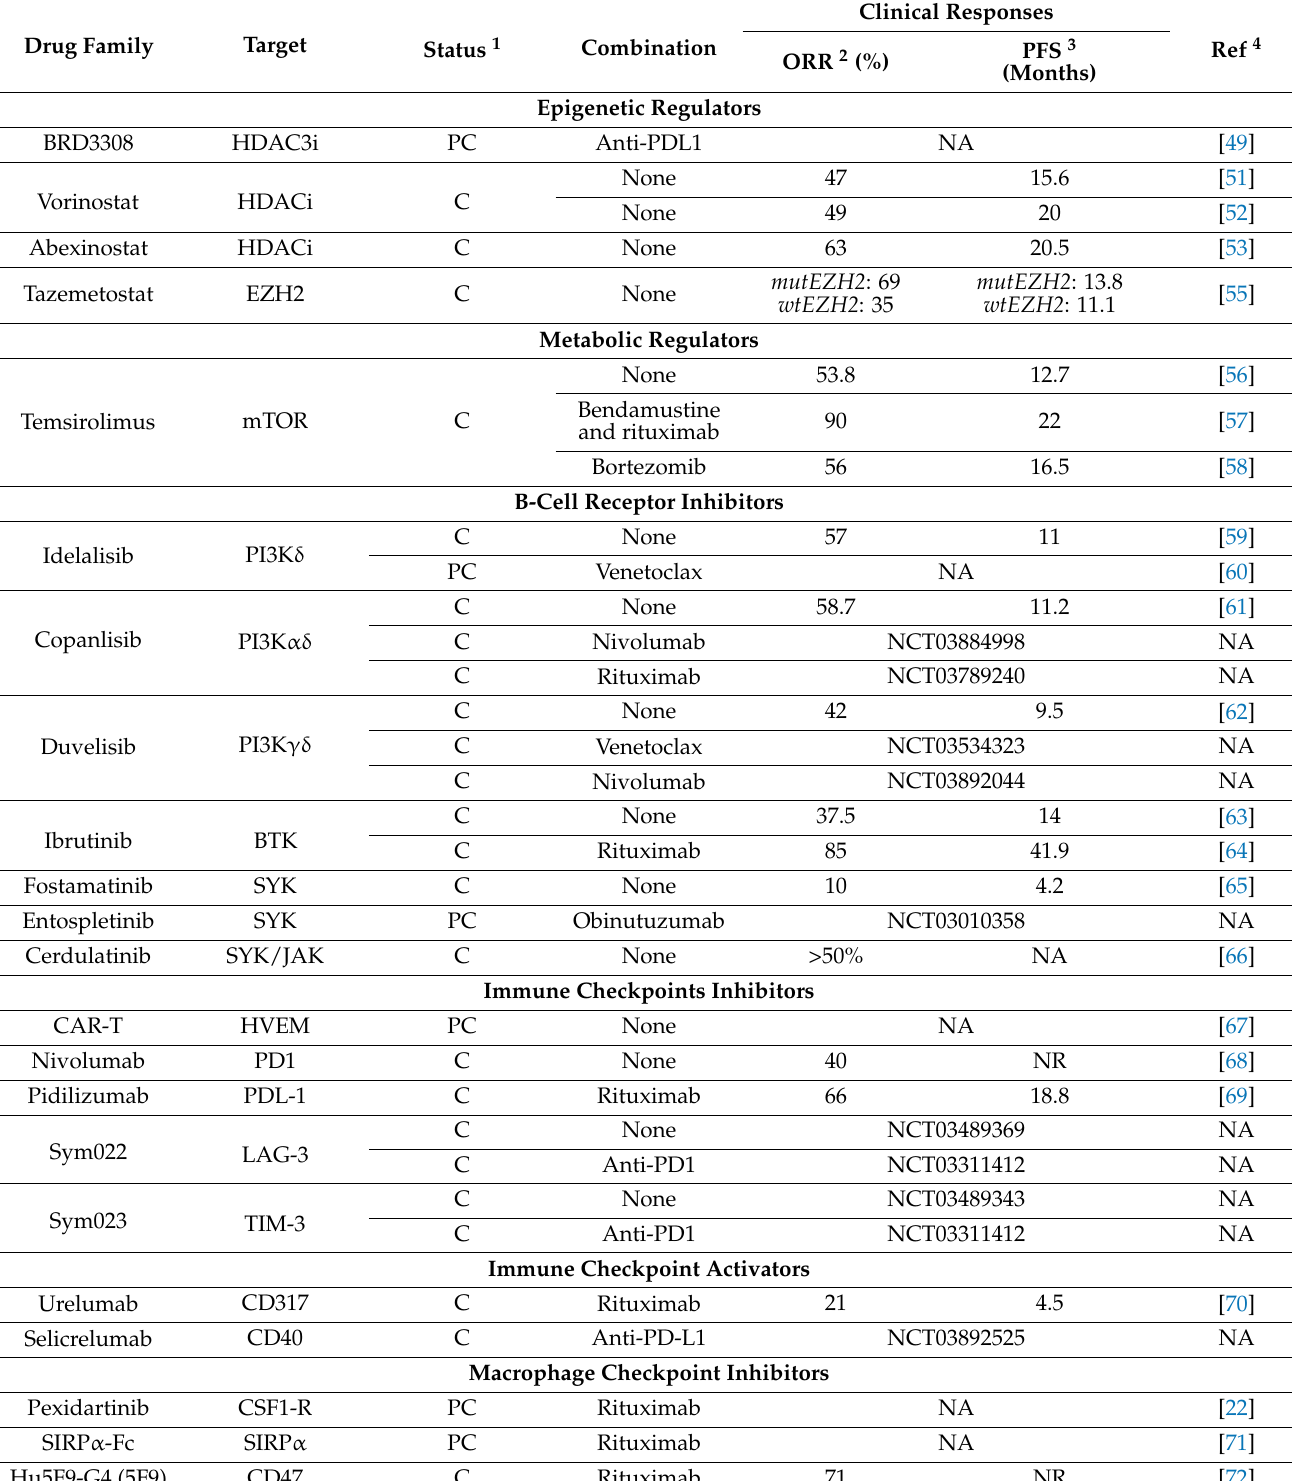
Table 1. Current therapies in clinical or preclinical status targeting FL-microenvironment crosstalk.